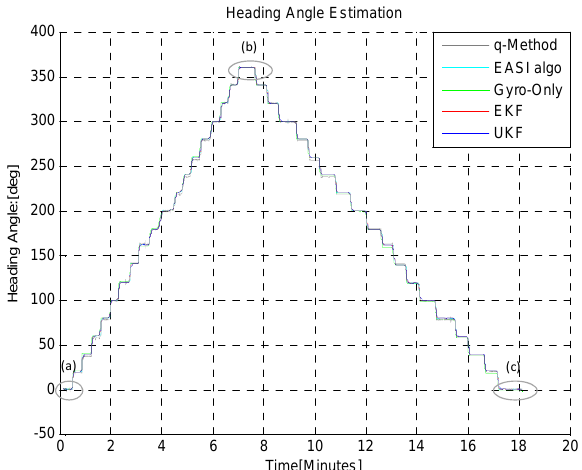
Figure 15. TiP with small steps (20°) in CW and CCW rotation. The EKF and UKF estimates end up with close to the initial heading angle but the gyro ‐ only solution shows clear divergence, more than 2° at the end of this experiment.